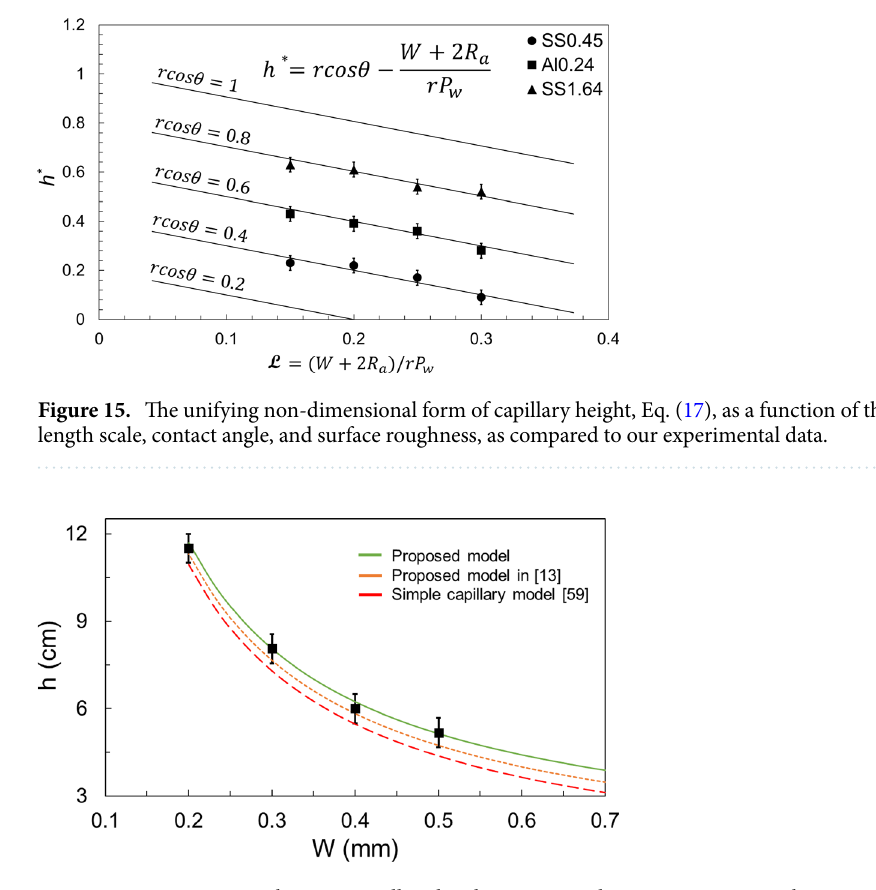
Figure 16. A comparison between capillary height in rectangular micro-grooves vs the micro-grooves’ width. The proposed model is compared to the model in 13 where surface roughness is not considered in the characteristic length scale (but is considered in the contact angle). Comparison is also made with a simple capillary model based on Young–Laplace equation 59 . Data for SLA1.03